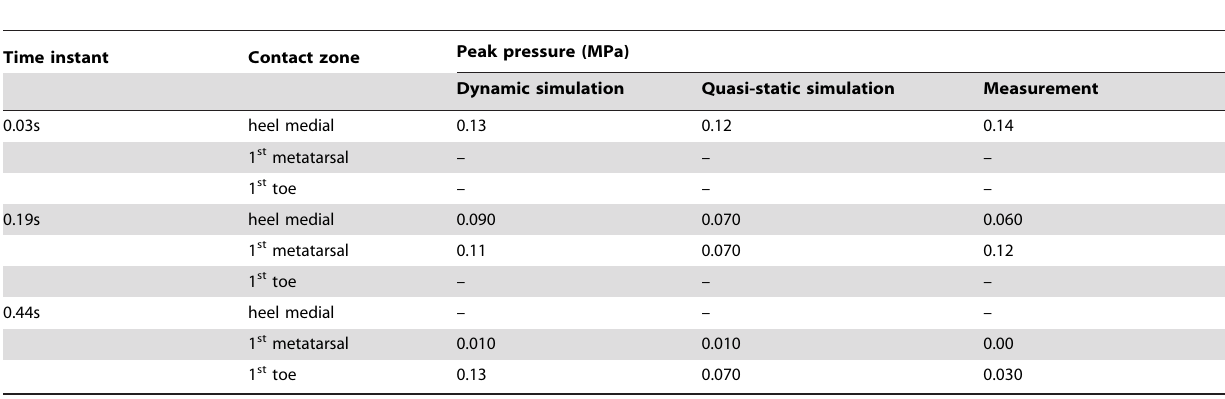
Table 3. The calculated peak pressure in different foot contact regions using both the dynamic FE simulation and the quasi-static FE simulation compared to the recorded pressure plate